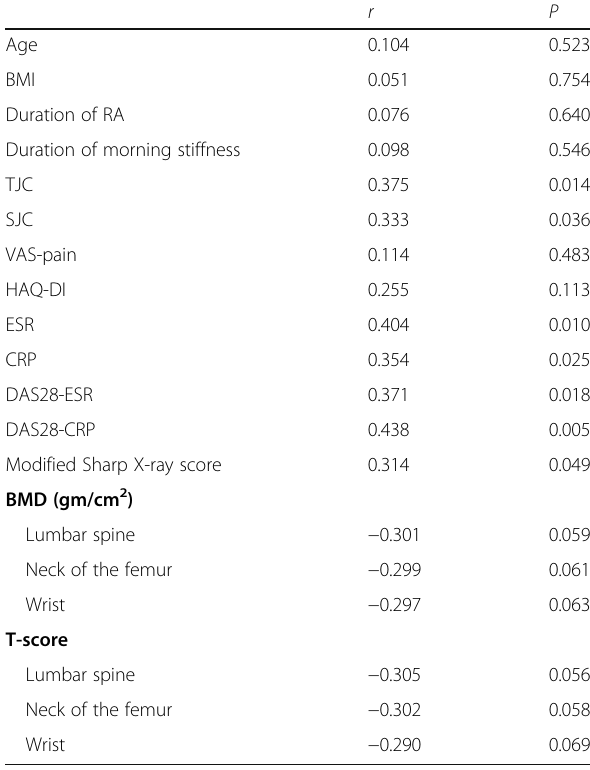
Table 5 Correlation of the sclerostin serum level with age, BMI, and RA related